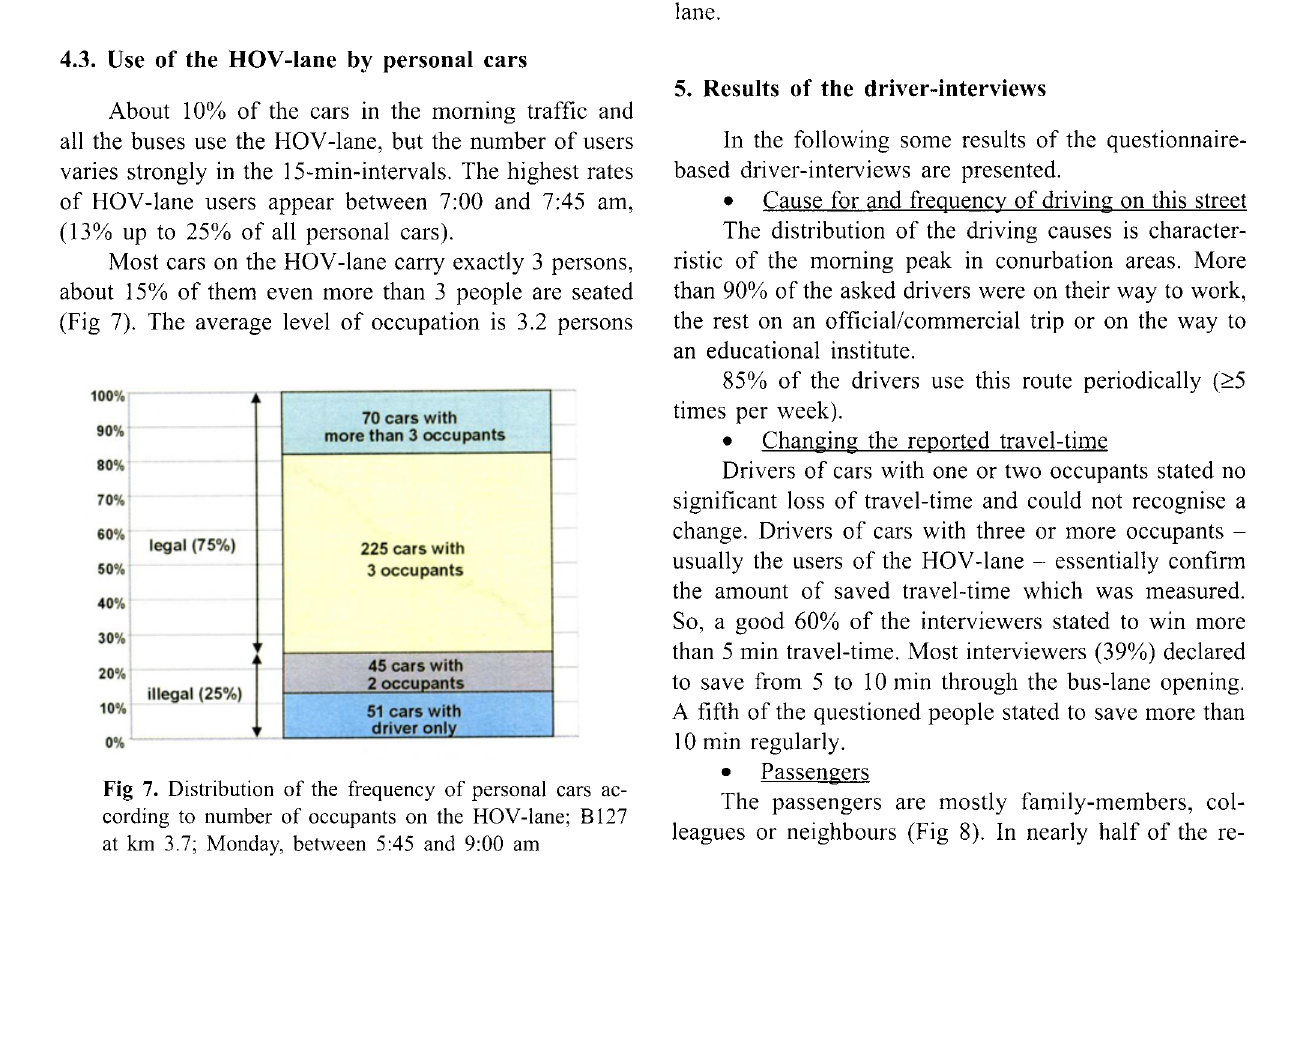
Fig 6. Medium savings of travel-time through usage of the HOY -lane, shown per vehicle and per 15 min, ve hicles heading towards Linz on the Bl27, between km 7.2 and km 3, I; depicted at the time when passing km 7.2 (Monday, between 6:15 and 9:00 am)